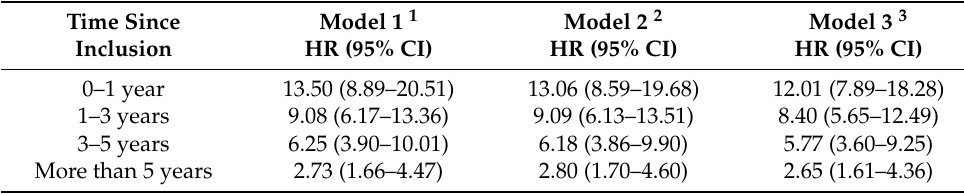
Table 3. Risk of pharmacological or hospital treatment for depression in 1324 patients with colorectal cancer compared with 6620 cancer-free comparison persons.